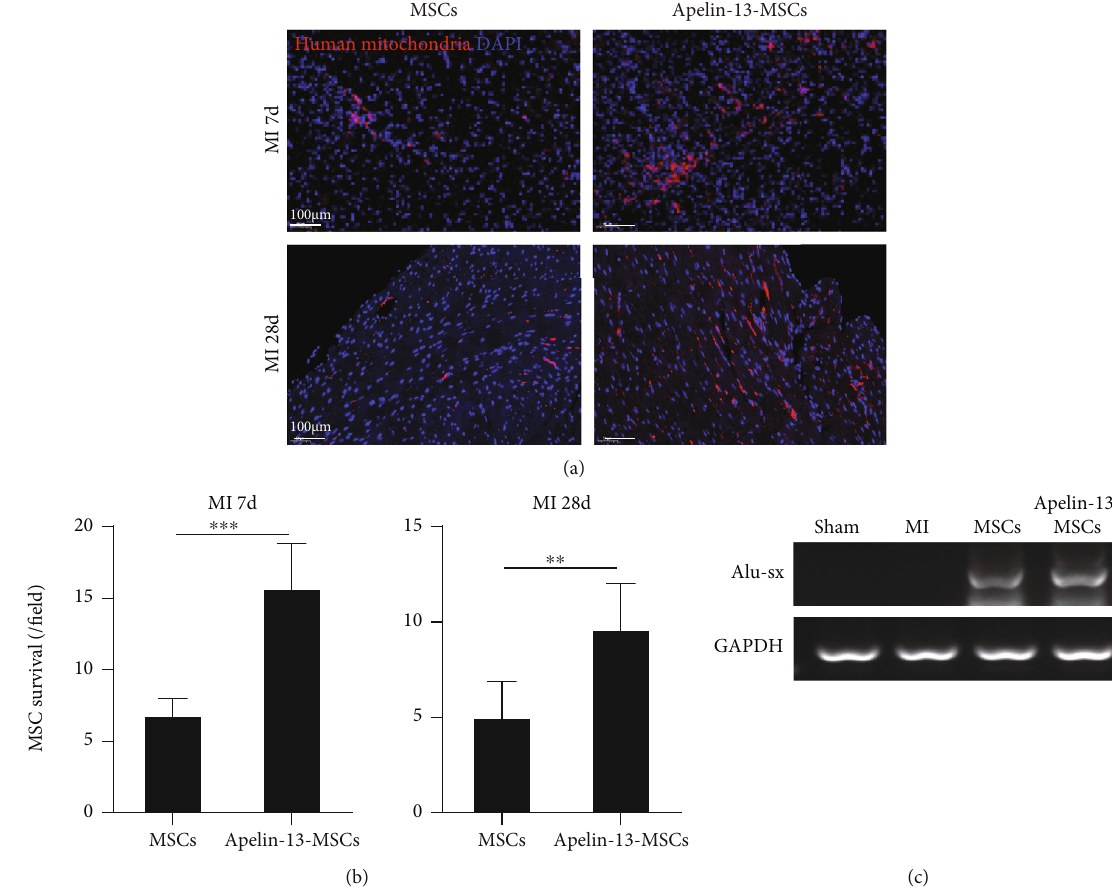
Figure 5: Apelin-13 pretreatment improves MSC survival in mice hearts following infarction. (a) Representative images of human mitochondria staining in the ischemic heart of mice at 7 days and 4 weeks among the di ff erent groups. (b) Quantitative analysis of human mitochondria positive cells in ischemic mice hearts at 7 days and 4 weeks among the di ff erent groups. (c) Alu-sx expression was evaluated by PCR in the sham, MI, MSCs, or Apelin-13-MSCs group. n = 6 mice for each group. Data are expressed as mean ± SD . ∗∗ p < 0 : 01 , ∗∗∗ p < 0 : 001